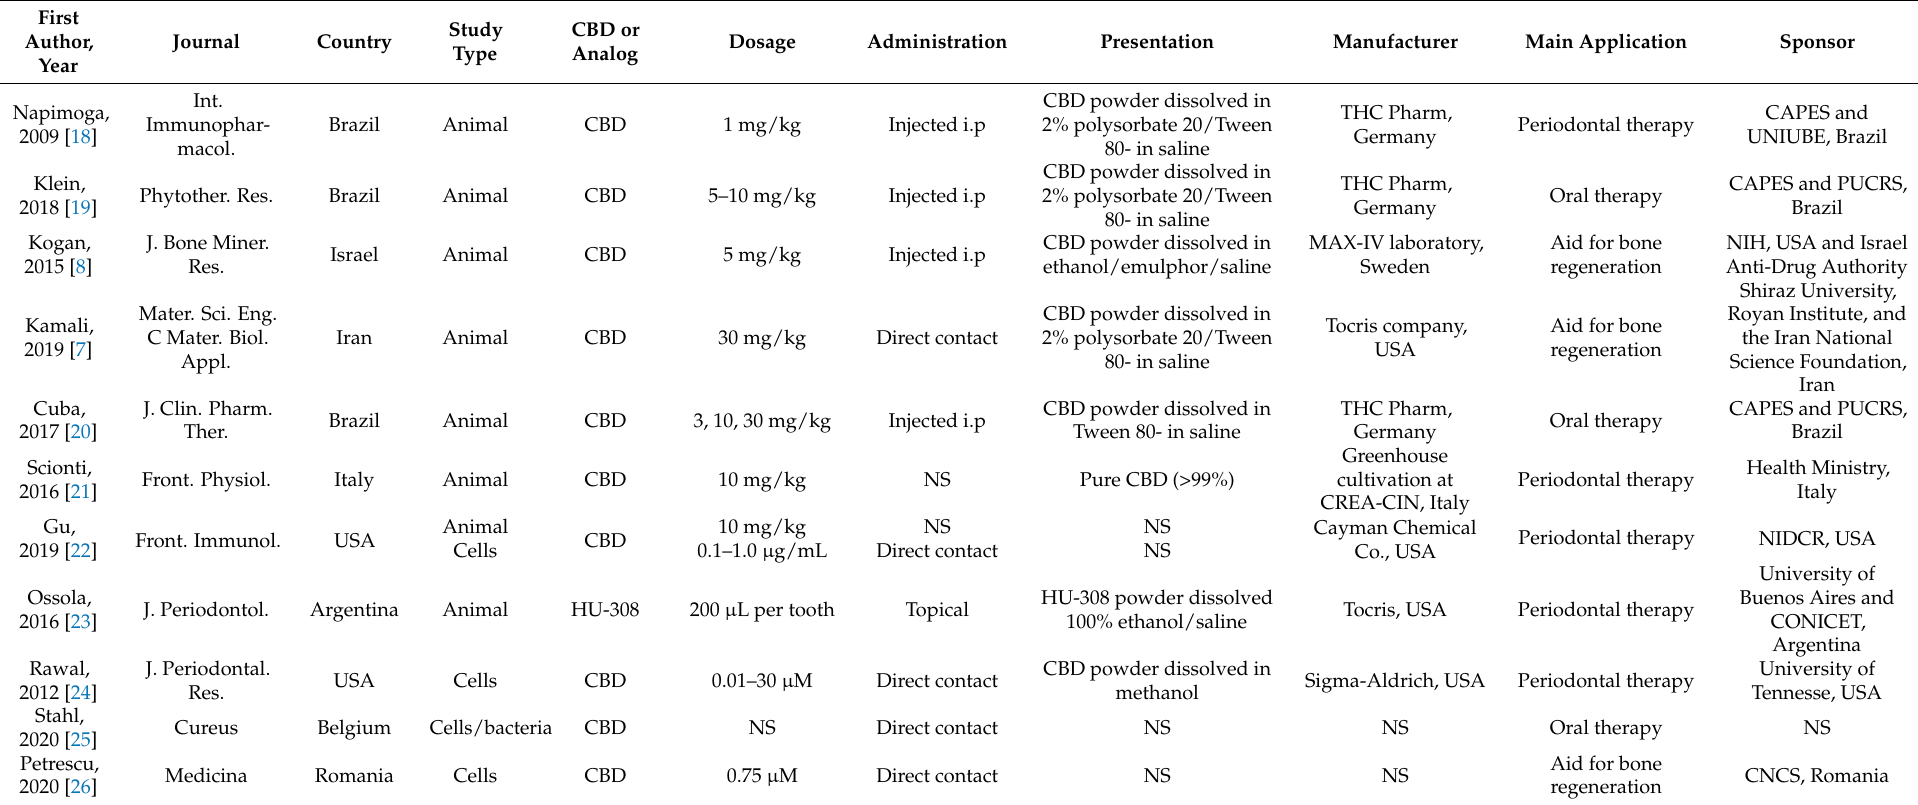
Table 2. Characteristics of the original articles included, n =